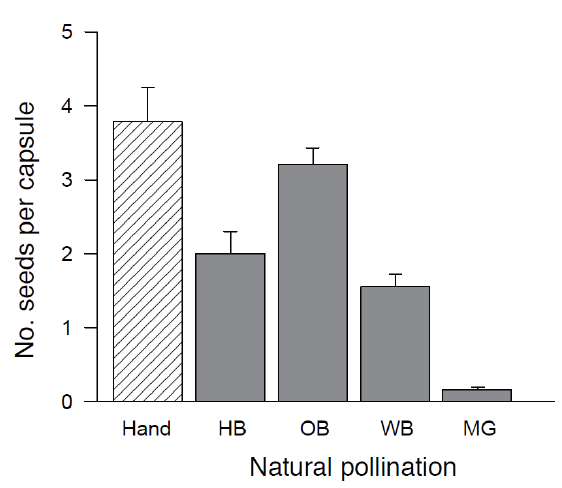
Figure 2. Seed production of Salix caprea in hand pollination and in natural pollination. Columns and bars indicate mean values and SEs. The data from daytime and night-time hand pollination are pooled, and those from natural pollination are shown separately for each